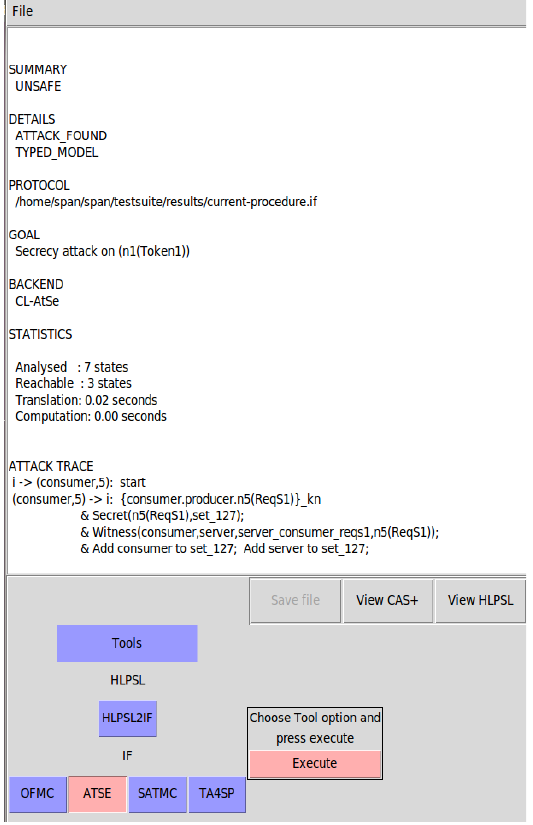
Figure 10. Formal analysis results of the NF service access procedure.